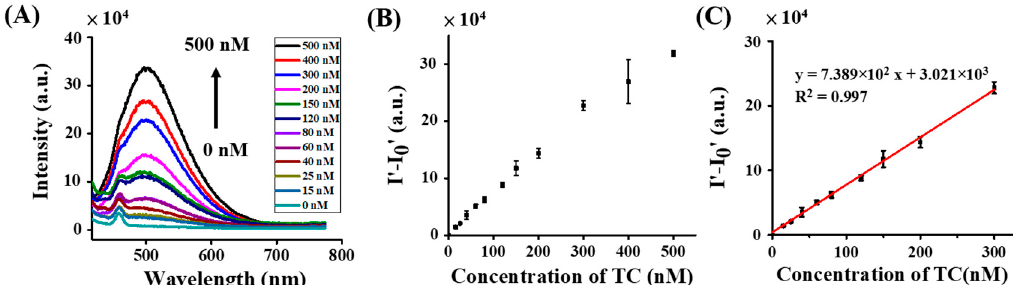
Figure 5. Fluorescence spectra of the samples containing ( A ) Zn 2+ (15 µ L, 31.3 mM) with the addition of different concentrations of TC (0–500 nM, 300 µ L). ( B ) The corresponding calibration curve obtained by plotting the difference of the fluorescence intensity of the samples containing Zn 2+ with (I (cid:48) ) and without (I 0 (cid:48) ) adding TC versus the concentration of TC. ( C ) Calibration plot with the linear dynamic range. I (cid:48) and I 0 (cid:48) were individually obtained from their differences of the corresponding fluorescence intensity at the wavelength of 500 nm to 750 nm in the resultant fluorescence